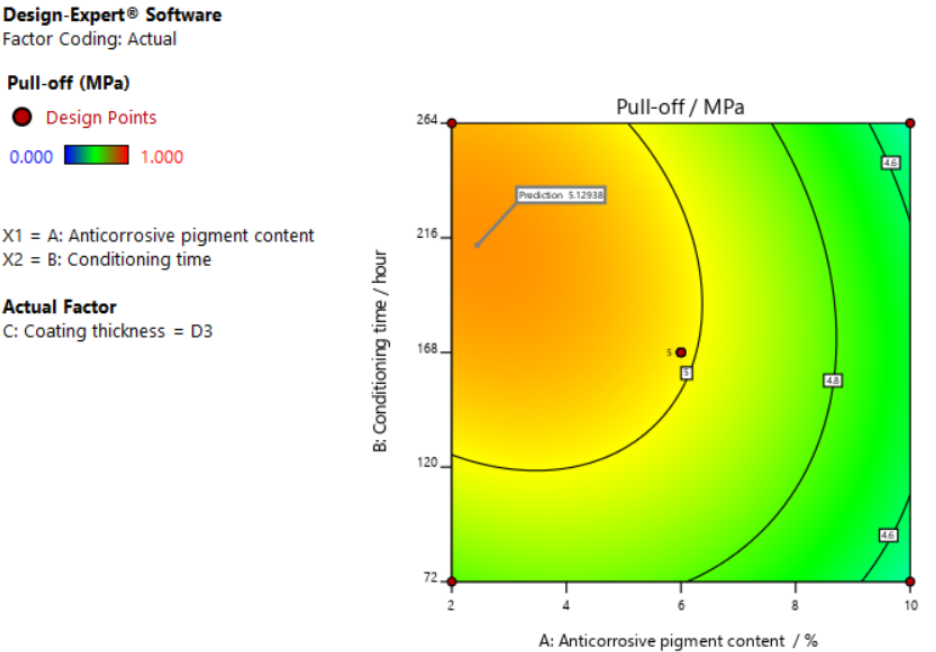
Figure 9. Optimal parameters for achieving the best adhesive properties.